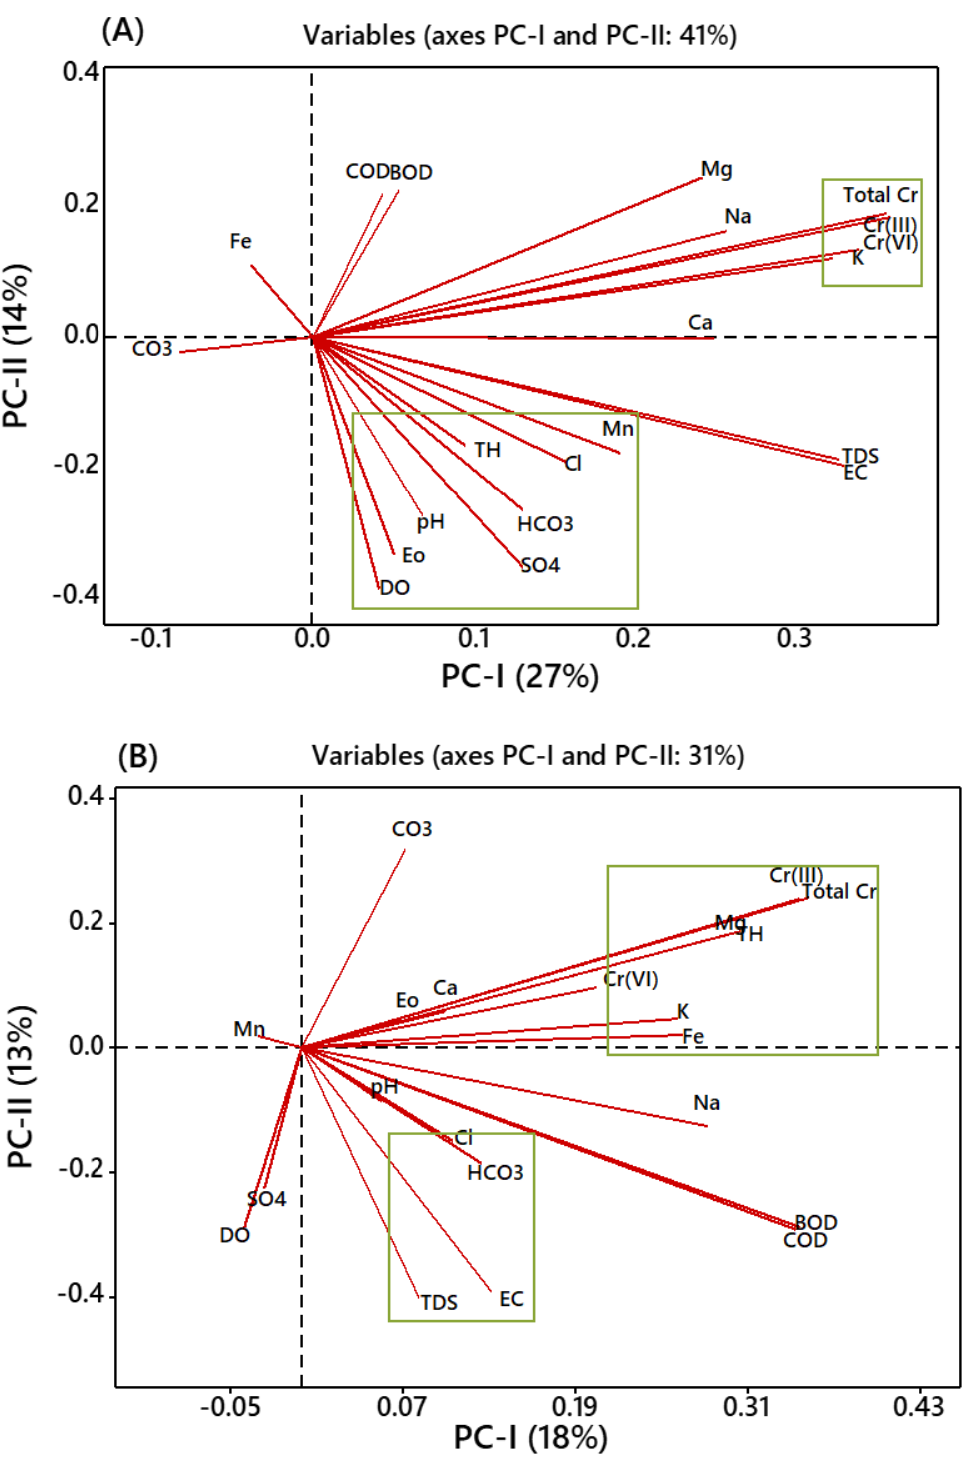
Figure 3. Loading plot of chromium (Cr) concentration and other physicochemical tannery industry wastewater parameters from Kasur, Punjab, Pakistan. ( A ) TWW-summer. ( B ) TWW-winter.